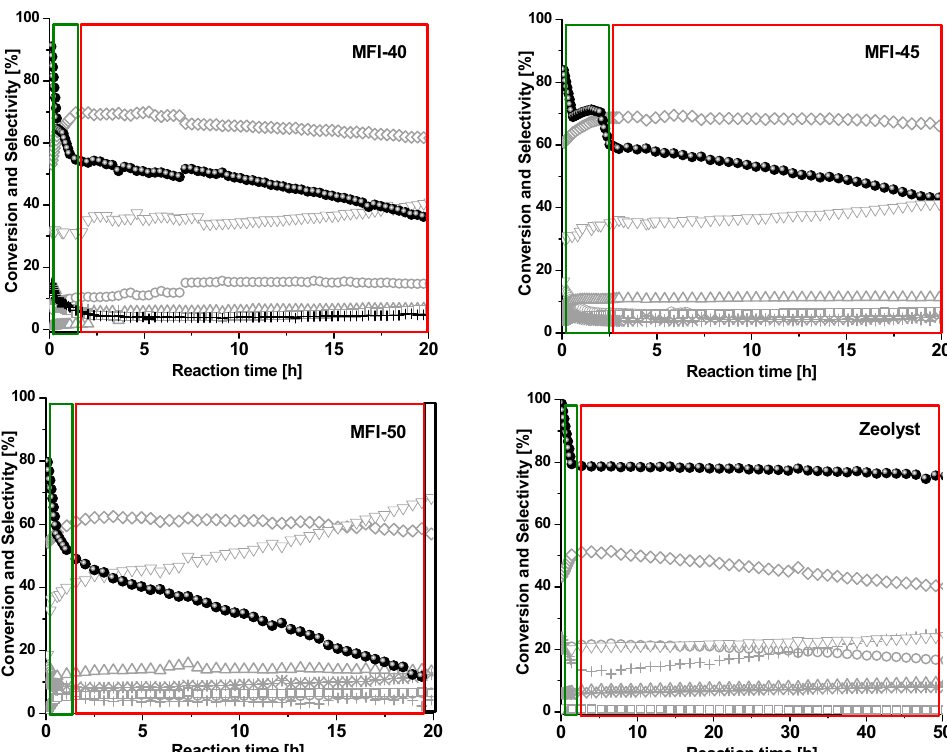
Figure 7. Methanol conversion and selectivity patterns of catalysts for the MTO reaction; reaction temperature: 500 °C and WHSV: 3 h − 1 ; ( ● ) Methanol conversion, ( ○ ) C 2= , ( ◊ ) C 3= , ( ∆ ) C 4= , ( □ ) C 5= , ( ▽ ) DME, (*) paraffin, and (+) aromatics selectivity. The green region corresponds to the initial stage of reaction; where the products formation is initiated, the red region indicates to the stable/slower deactivation; where the products formation reaches to steady state, and the black region relates to the deactivated stage, where the products formation decreased drastically (below